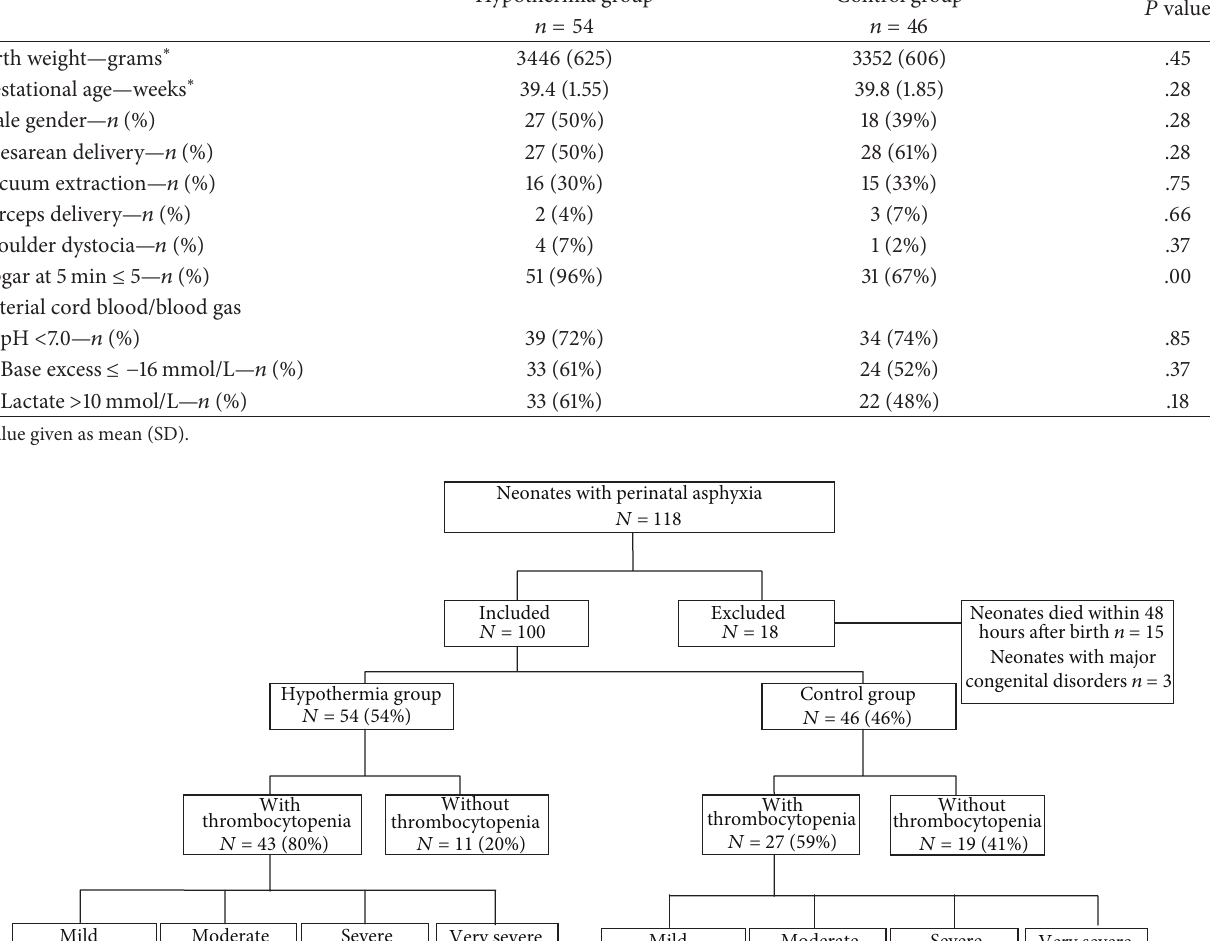
two-sided and were considered statistically significant at 𝑃 < .05 . Data analyses were performed using SPSS